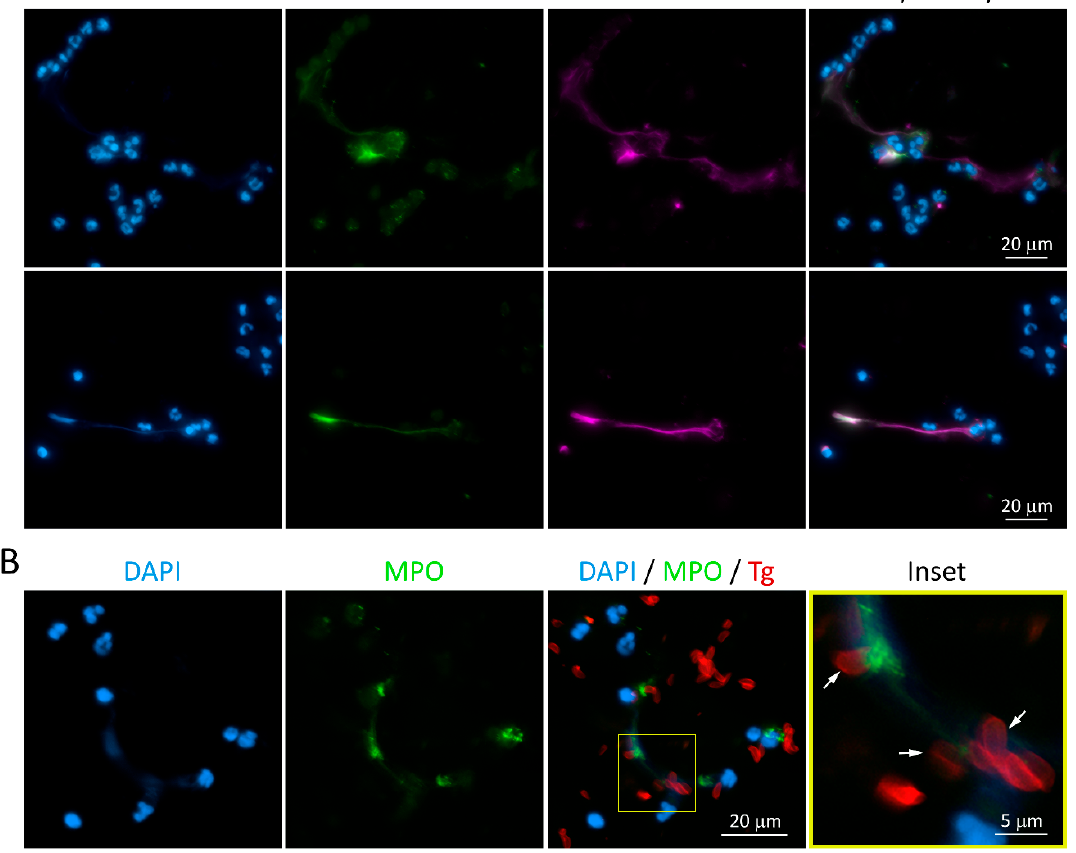
Figure 2. NET formation induced by Toxoplasma gondii tachyzoites. Neutrophils were incubated for 180 min with RH strain tachyzoites (5:1 parasites:neutrophil ratio), fixed and stained for myeloperoxidase (MPO) and histone H1 ( A ) or T. gondii ( B ). Neutrophils DNA was counterstained with DAPI. Inset shows a region containing several parasites entrapped in DNA ‐ MPO rich structures (arrows). Tg = T. gondii .